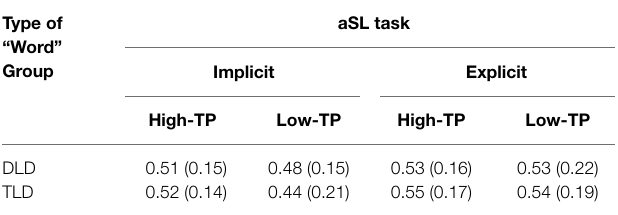
TABLE 2 | Mean (SD) of the number (Proportion) of correct responses for the High- and Low-TP “Words” in the implicit and explicit auditory SL task (aSL) tasks in the DLD and TLD groups.